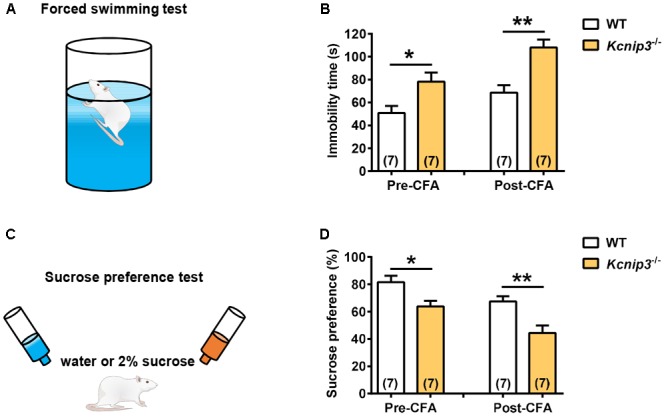
Enhanced depression-like behavior in Kcnip3-/- rats under both normal and inflammatory pain conditions. (A) Schematic diagram of the forced swimming test. (B) Immobility time of wild-type and Kcnip3-/- rats before (left) and 1 day after CFA injection (right). n = 7 for both groups. ∗p < 0.05, ∗∗p < 0.01, unpaired t-test. (C) Schematic diagram of the sucrose preference test. (D) Preference for sucrose, expressed as a percentage of the volume of sucrose intake over the total volume of fluid intake of wild-type and Kcnip3-/- rats before (left) and 1 day after CFA injection (right). n = 7 for both groups. ∗p < 0.05, ∗∗p < 0.01, unpaired t-test.